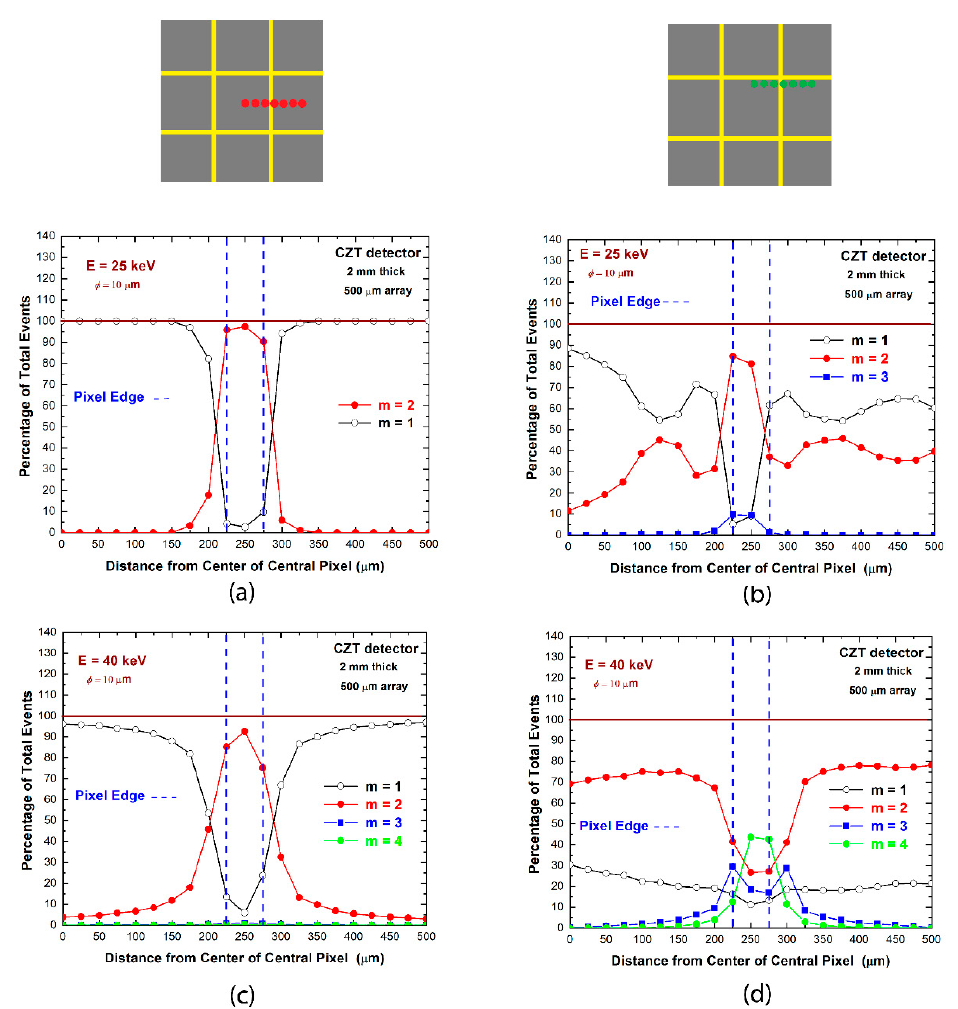
Figure 5. Results of microscale line scanning with synchrotron X-rays between the centers of two adjacent pixels; ( a , b ) at energy below (25 keV) and ( c , d ) above (40 keV) the K-shell absorption energy of the CZT material. The multiplicity m at various beam positions was measured: ( a , c ) near the central region of both pixels, ( b , d ) near the edge region.